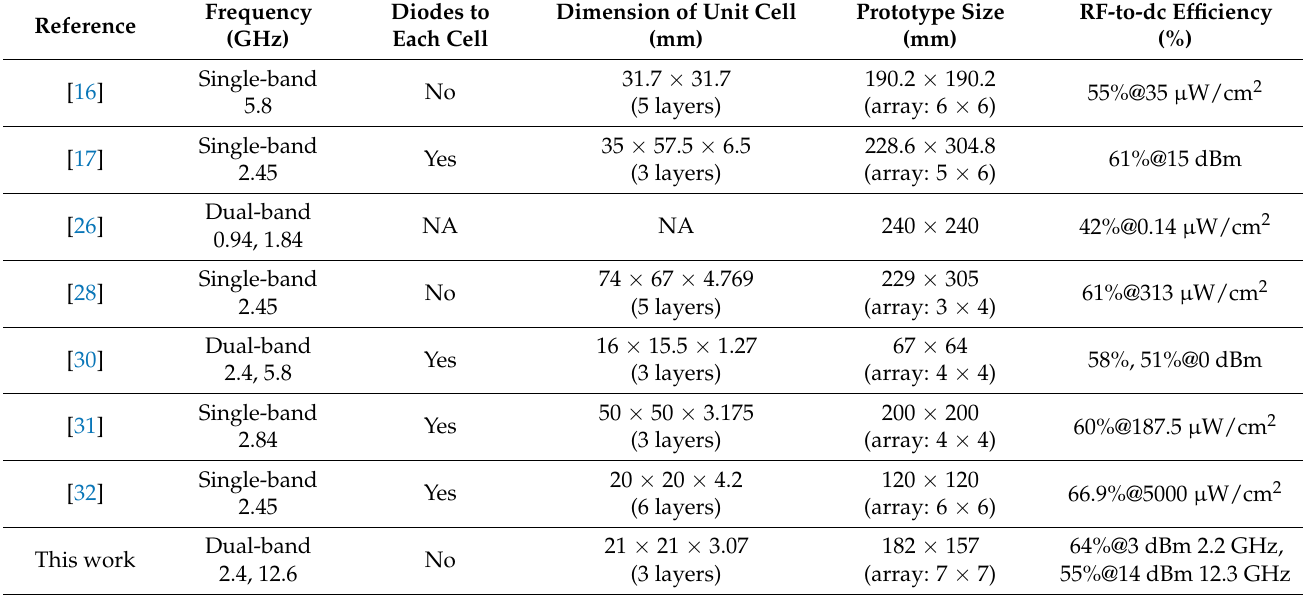
Table 1. Comparison of the proposed metasurface array with related works.